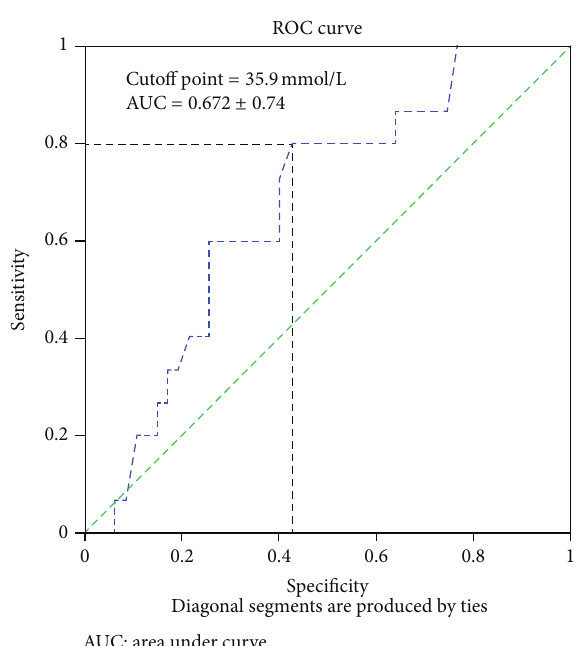
Figure 1: Cox regression analysis shows factors that independently associate with coronary artery calcification appraised by calculation of Agatston score index value.